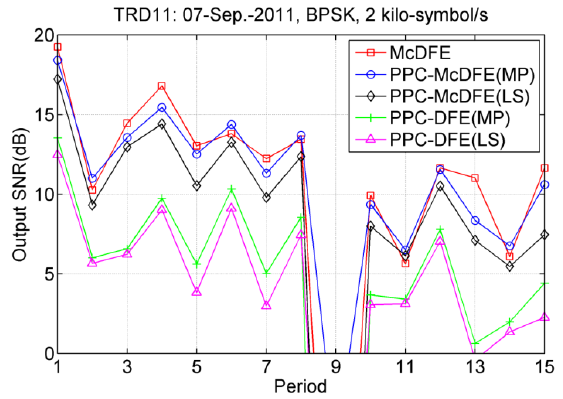
Figure 13. Performance in terms of output SNR at a symbol rate of 2